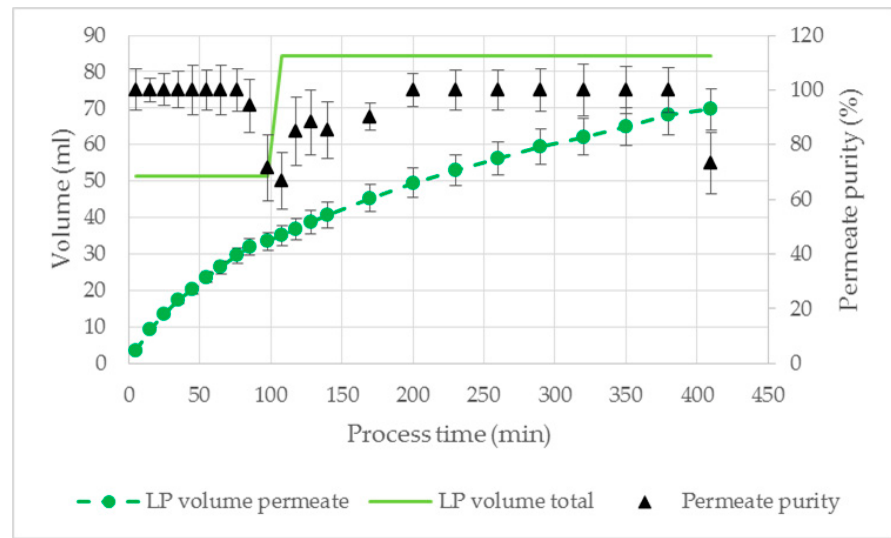
Figure 11. Volume of LP and permeate purity for phase separation of ATPS1 with cultivation broth as feed component. V = 100 mL, TMP = 100 mbar, dP = 250 mbar, Q = 16.7 mL/min. LP: light phase.